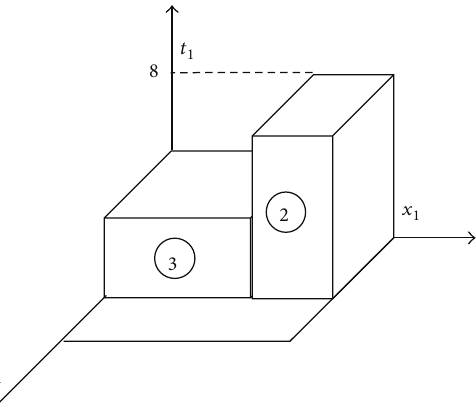
Figure 5: The status of place 1 while activity 2 is put.